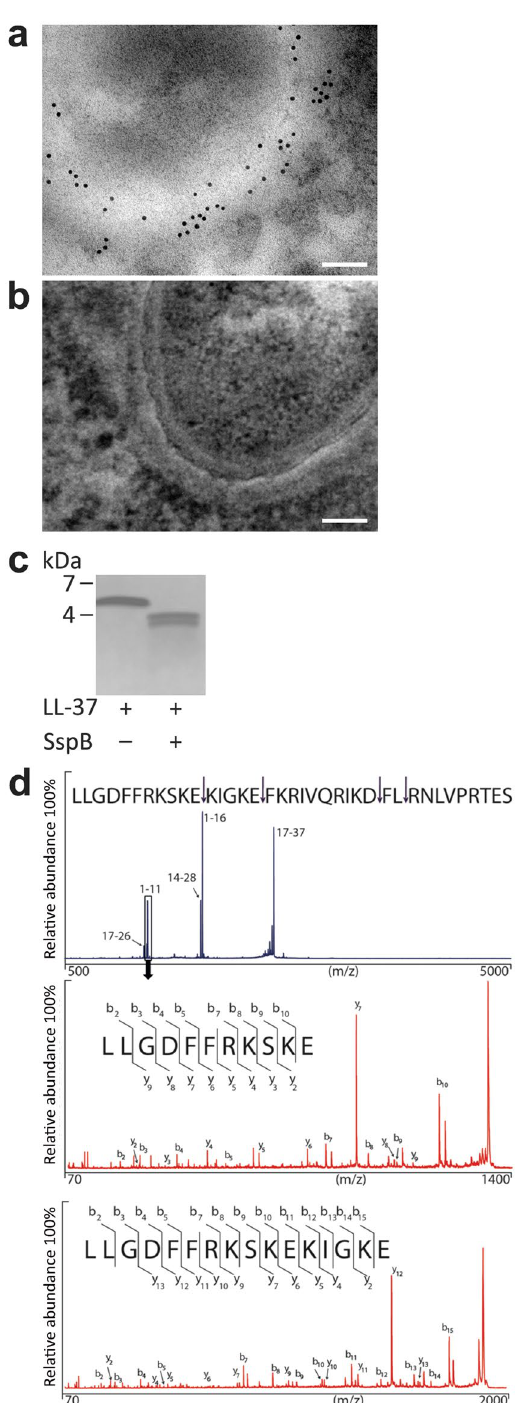
Figure 3. The S . aureus derived protease staphopain in bacterial biofilm and degradation of LL-37. ( a ) Visualization of staphopain protease at the bacterial surface of cocci-like bacterial structures in skin biopsy from S . aureus colonized lesional skin of patient with AD. Binding of gold-conjugated antibodies, directed against the S . aureus derived proteases ScpA and SspB, are shown at the surface of coccoid bacteria. Scale bar 100 nm. ( b ) In the control experiments, no unspecific binding of gold-conjugated secondary IgG antibodies was observed, scale bar 100 nm. ( c ) LL-37 was incubated with and without S . aureus SspB and analysed using SDS-PAGE (Novex ® 10–20% Tricine Gel). Several distinct low molecular weight fragments were observed and further analyzed by MS. ( d ) Mass spectrometry analysis (depicted in blue) of the proteolytic digested LL-37 by SspB, resulting in 100% sequence coverage. The arrows illustrate proteolytic cleavage sites, and MSMS experiment (depicted in red) on the 1–11 peptide resulted in an almost complete y- and b-ion series that identifies the 1–11 sequence LLGDFFRKSKE. Moreover, the analysis revealed an additional fragment (LLG16) (lower